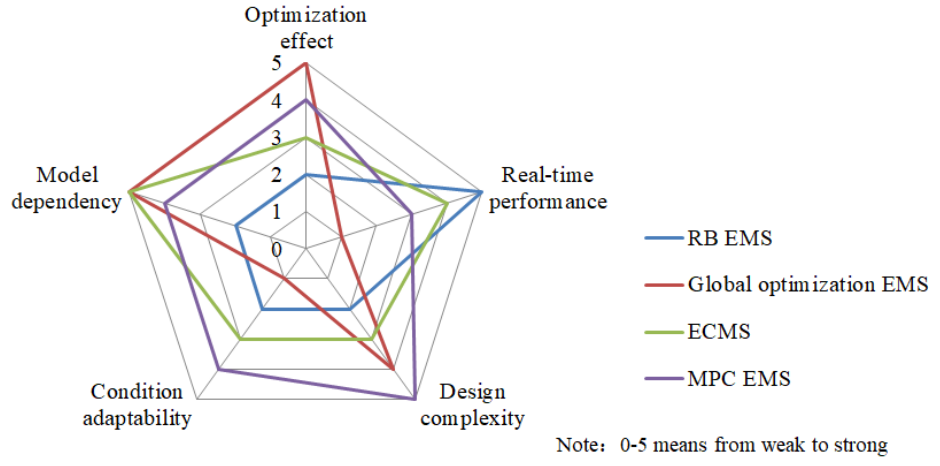
Figure 16. Performance comparison of four EMSs.